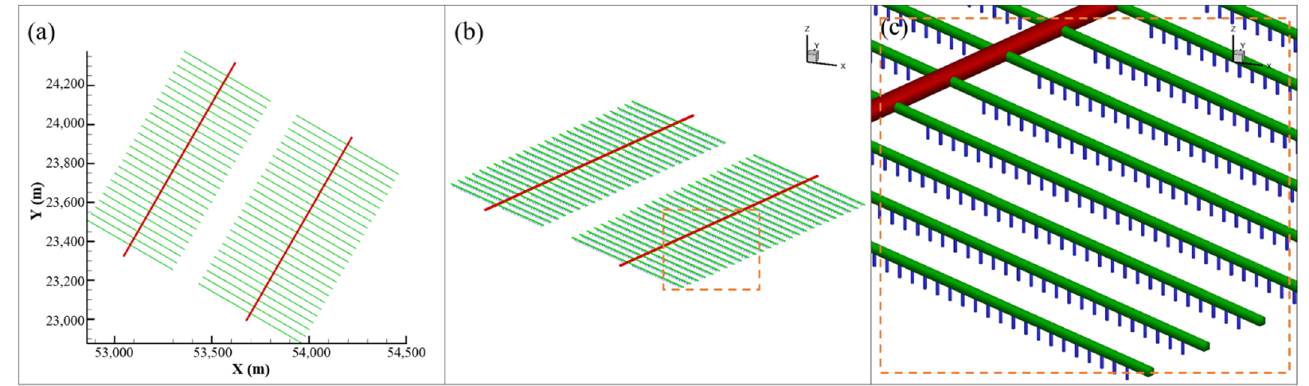
Figure 2. The basic disposal facility in this study. ( a ) The layout and location of the basic disposal facility are composed of two panels; ( b ) The design of MTs (in red color) and DTs (in green color). There are 2 MTs and 104 DTs; ( c ) The close view of parts of a MT (in red color), DTs (in green color), and DHs (in blue color). There are 2860 DHs in this conceptual disposal facility in this study.